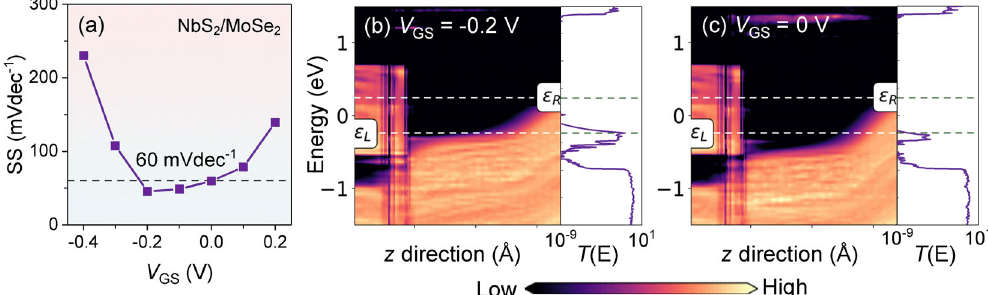
Fig. 4 The SS and PLDOS of NbS 2 /MoSe 2 CM-FET. a The SS of NbS 2 /MoSe 2 CM-FET as a function of V GS . b, c PLDOS of NbS 2 /MoSe 2 CM-FET with the barrier ( Φ B ) ( b ) above ( V GS = -0.2 V) and ( c ) below ( V GS = 0 V) the E VG of